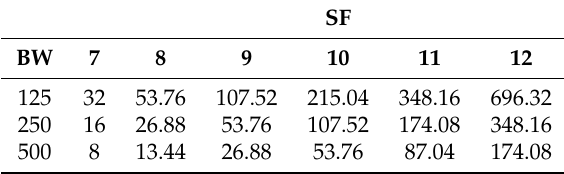
Table 8. Values of T packet in ms depending on BW and SF, with CR = 1, CRC disabled, implicit header. SF BW 7